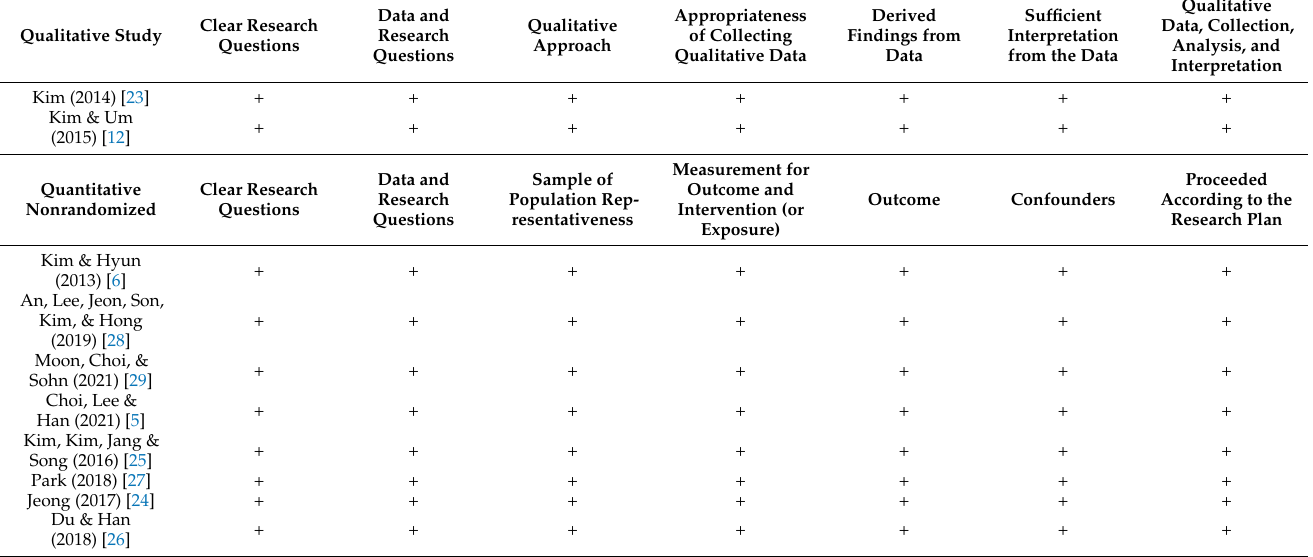
Table A1. Mixed Methods Appraisal Tool (MMAT) for quality